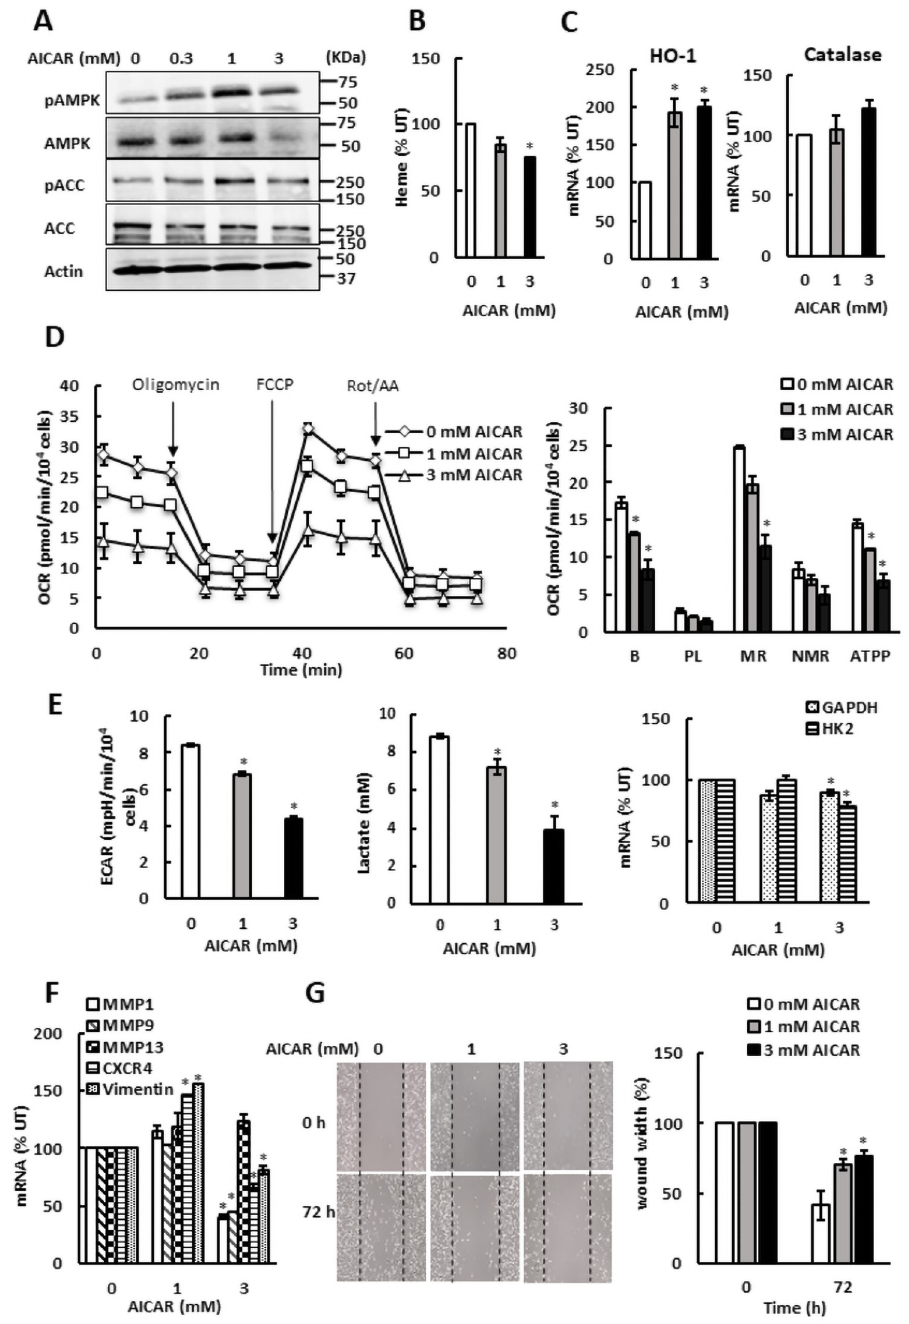
Fig 5. AMPK inhibits mitochondrial respiration and aerobic glycolysis in MDA MB 231 cells. (A) MDA MB 231 cells were treated with 0, 0.3, 1, and 3 mM AICAR for 24 h and whole cell extracts were analyzed by Western blotting using antibodies against pAMPK, AMPK, pACC, ACC, and actin. The figure represents typical results from three independent experiments. (B) Cellular heme levels in MDA MB 231 cells treated with AICAR for 24 h. (C) HO-1 and catalase mRNAs were analyzed by qRT-PCR in MDA MB 231 cells treated with AICAR for 24 h. (D) OCR was measured in MDA MB 231 cells treated with AICAR for 24 h. The experiment was performed as described in Fig 1E. (E) ECAR, lactate accumulation in the medium, and GAPDH and HK2 mRNA levels in MDA MB 231 cells treated with AICAR for 24 h. (F) Expression of metastatic genes in MDA MB 231 cells treated with AICAR for 24 h. (G) Migration of MDA MB 231 cells treated with AICAR for 72 h analyzed by wound healing assay (n = 3). (A-G) The experiments were repeated three times, and the numerical results are shown as means ± S.D. Values that are statistically different ( p < 0.05) from the control (untreated cells) are indicated by an asterisk. https://doi.org/10.1371/journal.pone.0260400.g005 PLOS ONE | https://doi.org/10.1371/journal.pone.0260400 November22,